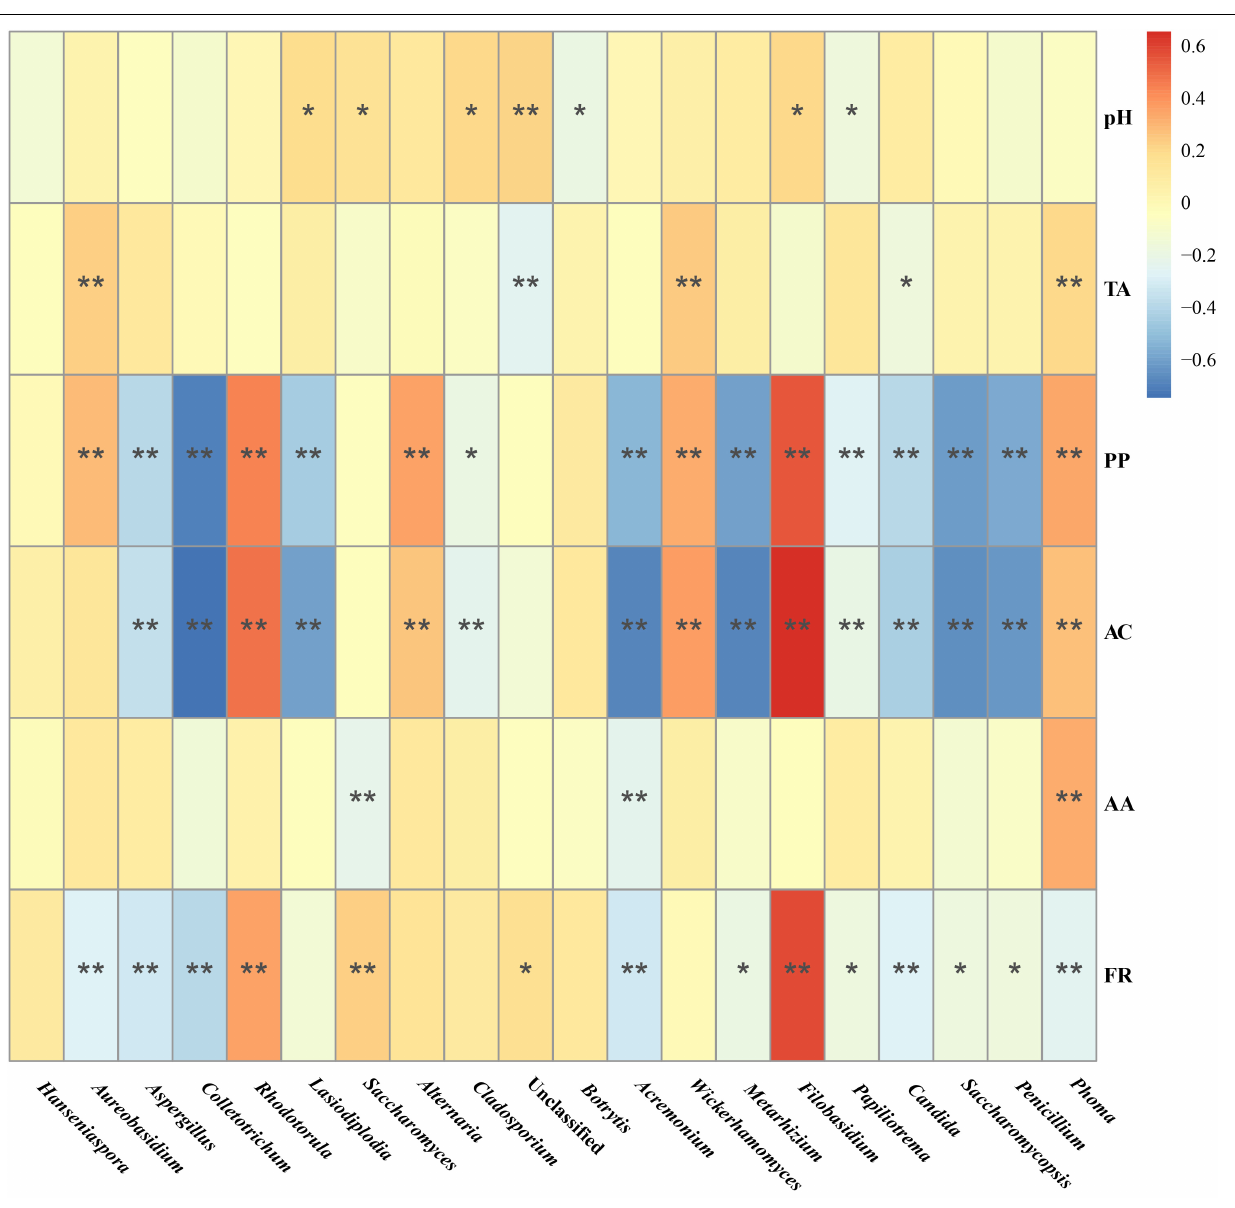
FIGURE 7 | Spearman correlation analysis of the correlation between the fungal composition in the Marselan fermented samples and physicochemical index variations of the spontaneous fermented wine. The different color intensities represent the degree of correlation. “*”, significant ( P < 0.05); “**”, extremely significant ( P < 0.01). Factors abbreviations: total acid (TA), polyphenol (PP), anthocyanins (AC), acetic acid (AA), and fermentation rate